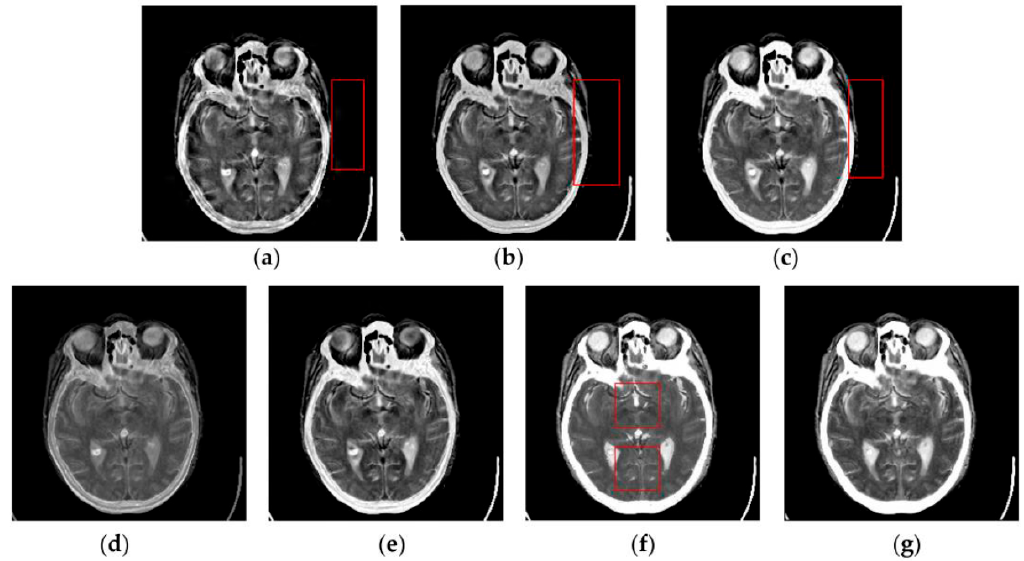
Figure 8. Fused results of the evaluated methods for the second group of source images shown in Figure 6c,d: ( a ) the DWT method; ( b ) the NSCT method; ( c ) the NSCT-SR method; ( d ) the m-PCNN method; ( e ) the PCNN-NSCT method; ( f ) the SCM-F method; and ( g ) the SCM-M method.